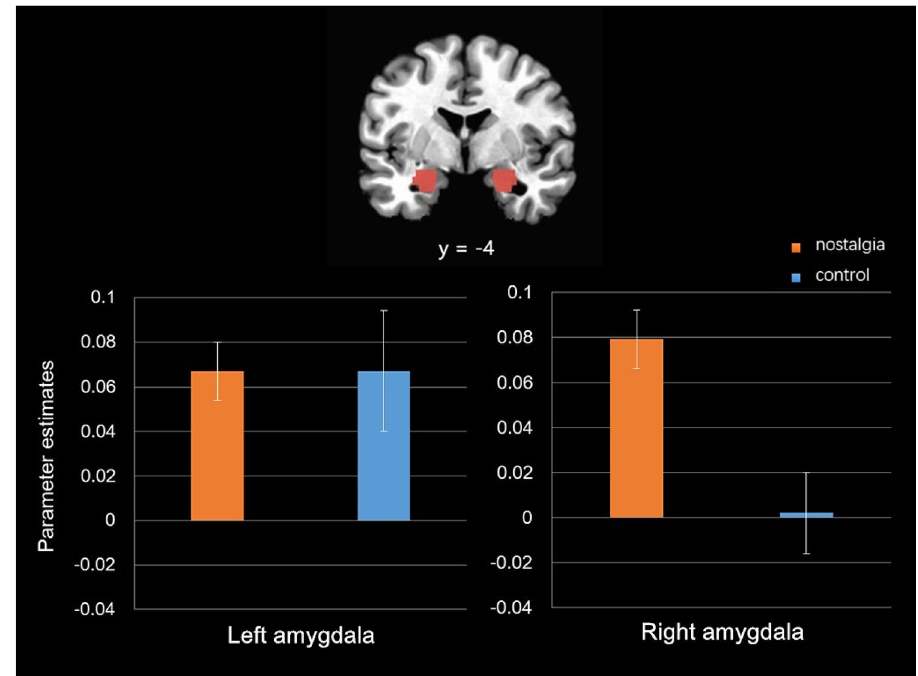
Figure 1. Results of the ROI analyses on left and right amygdala (defined by anatomical regions). Νostalgic (relative to control) participants showed greater right amygdala (but not left amygdala) activation in response to death-related versus neutral words. Error bars show standard errors.